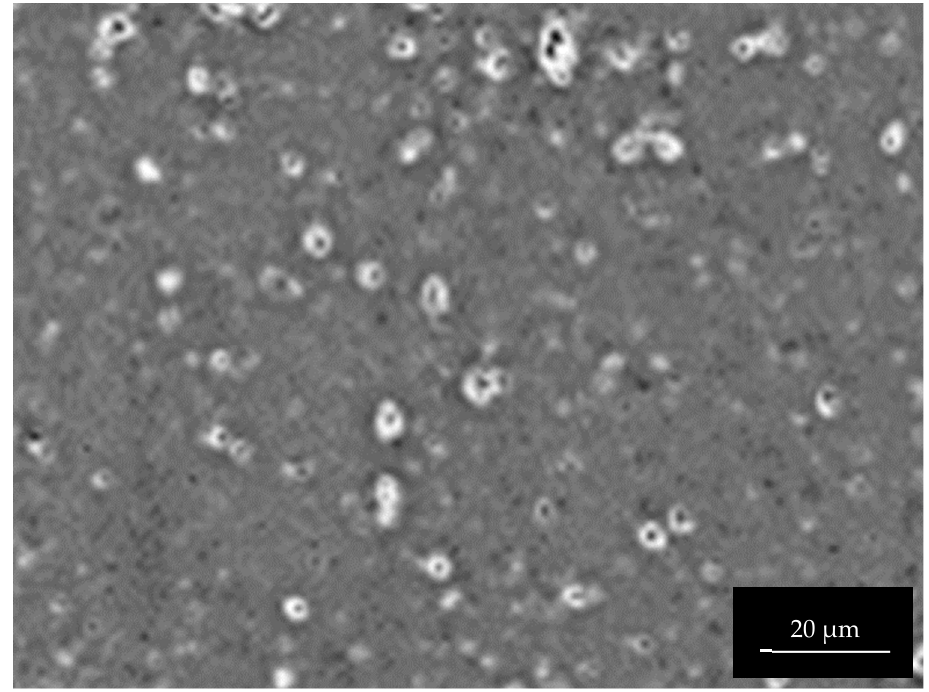
a = 0. Figure 2c was enlarged to 500%.